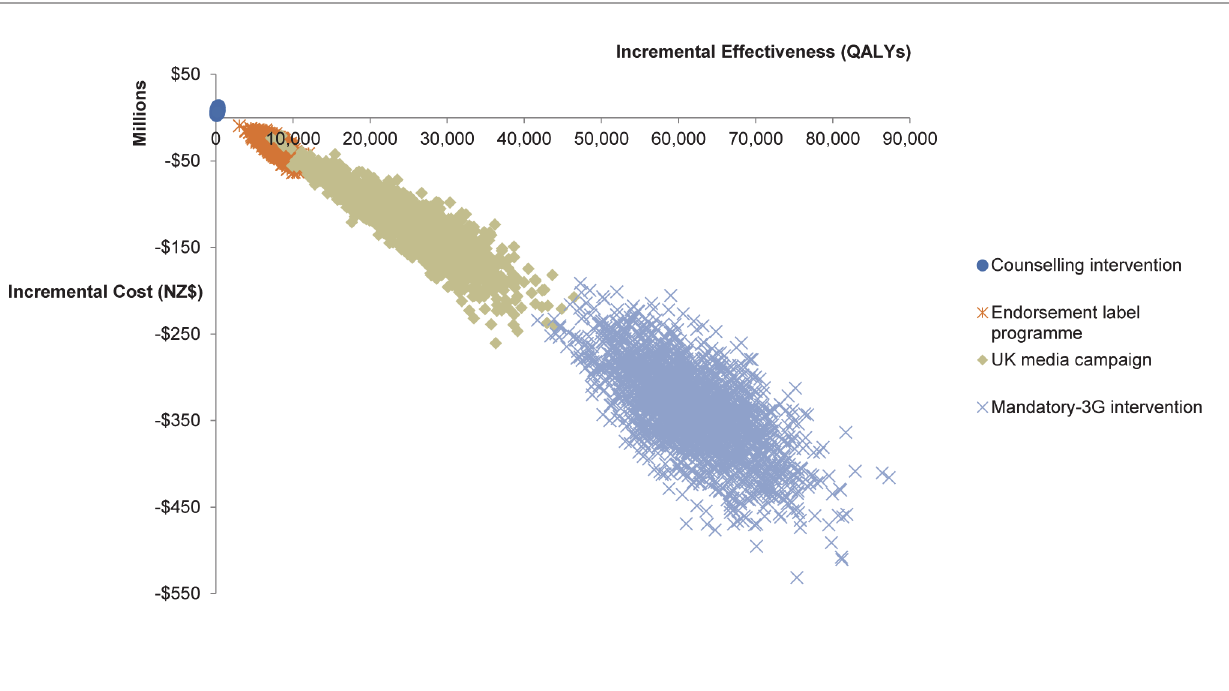
Fig 2. Cost-effectiveness plane with further detail on four of the salt-reduction interventions on the New Zealand adult population (for comparisons with the other interventions — see Fig 1).